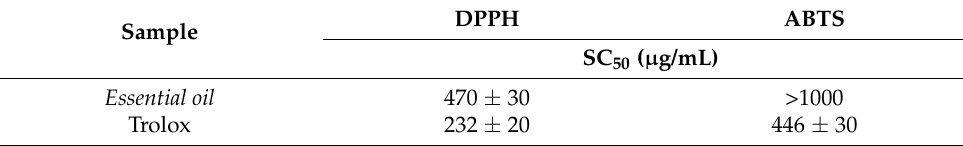
Table 5. Antioxidant activity of essential oils of Annona cherimola